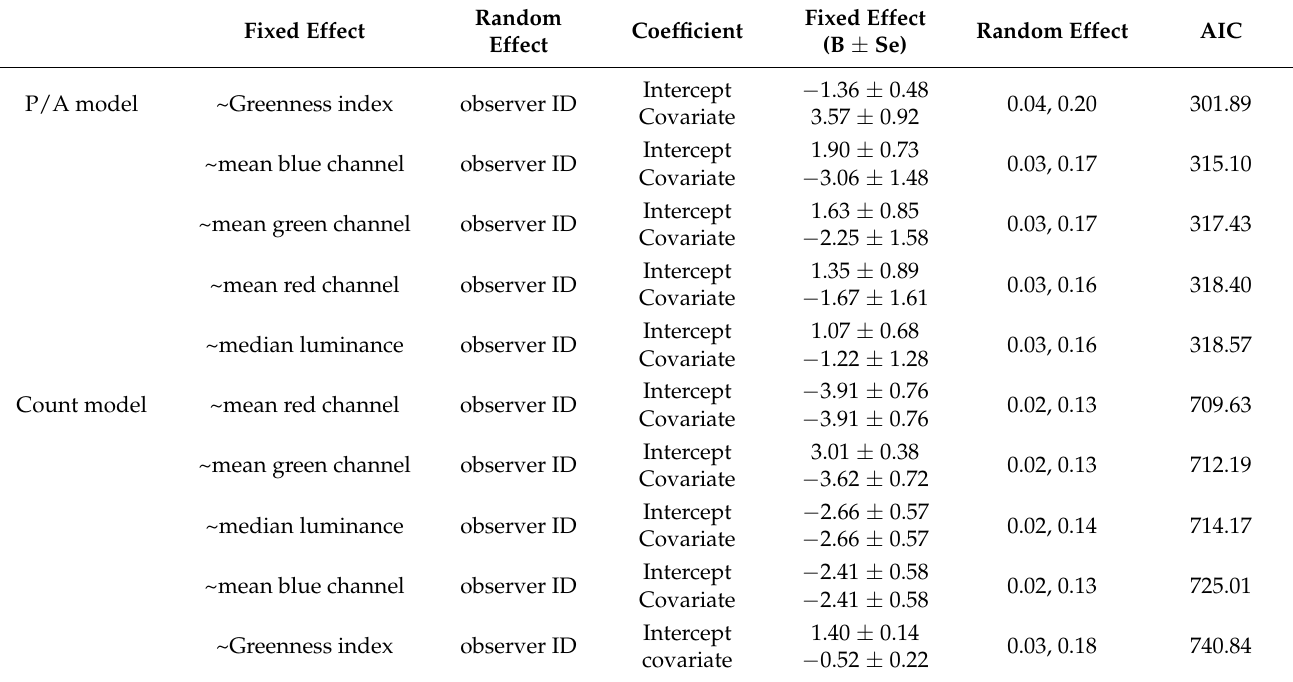
Table A5. Model estimates from the ten separate GLMERs for UAV P/A ( n = 234, 6 observers) and UAV count model ( n = 179, 6 observers). The coefficients are on a logit scale for the P/A models and Poisson scale for the count models. Bold denotes significant covariate effects ( p < 0.05). Random effect is reported as variance and standard